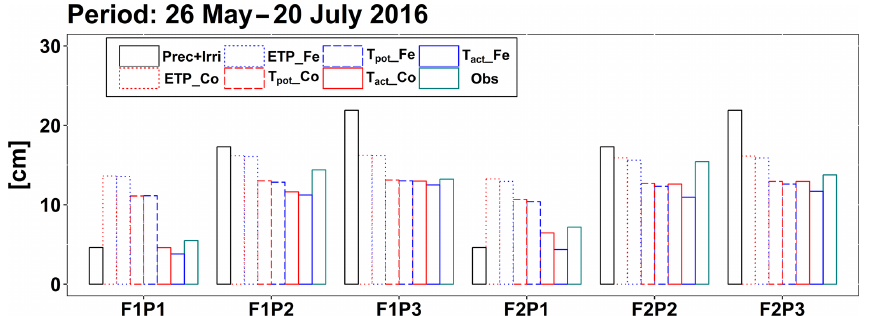
Figure 6. Cumulative precipitation and irrigation (Prec + Irri), potential evapotranspiration (ETP), potential transpiration ( T pot ), and actual transpiration ( T act or RWU) simulated by the Couvreur (Co) and Feddes (Fe) models and measured transpiration by sap flow sensors (Obs) from 26 May to 20 July 2016 in the sheltered (P1), rainfed (P2), and irrigated (P3) plots of the stony soil (F1) and the silty soil (F2).